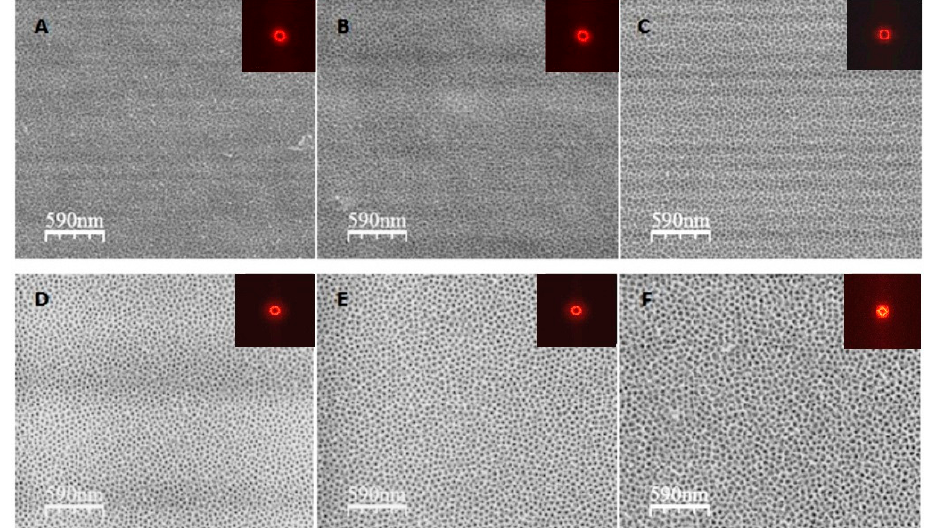
Figure 2. Top-viewfield emission scanning electron microscopy (FE-SEM) images and fast Fourier transform (FFT; right hand upper inserts) of nanoporous oxide formed by two-step anodization of FeAl 3 intermetallic alloy at voltages in the range of 10–22.5 V with a step of 2.5 V ( A – F